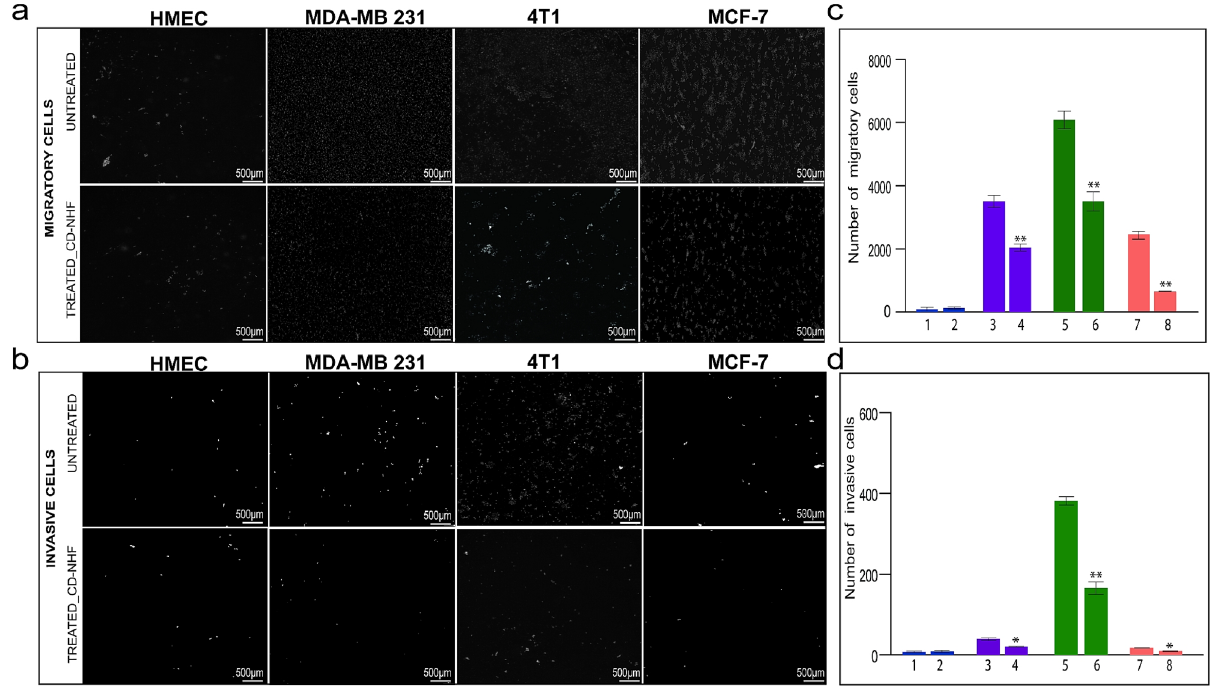
Figure 1. Effect of CD-NHF in Migration and Invasion assay. a. Migration; b. Invasion. 1,2 HMEC (1-untreated, 2-treated with 5% CD-NHF); 3,4 MDA-MB-231(3-untreated, 4-treated with 5% CD-NHF);